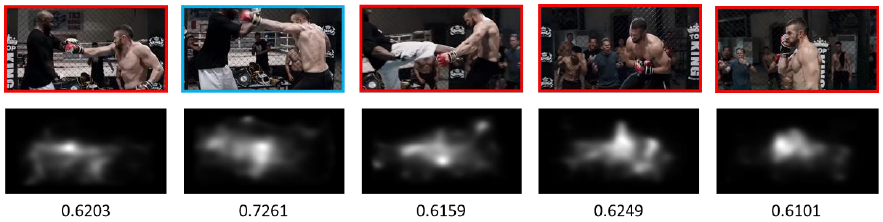
Figure 2. Sample frames from movie ‘Undisputed II’ along with their saliency maps. The frames with red bounding boxes are discarded while the frame in blue is selected as a key-frame with a maximum saliency score of